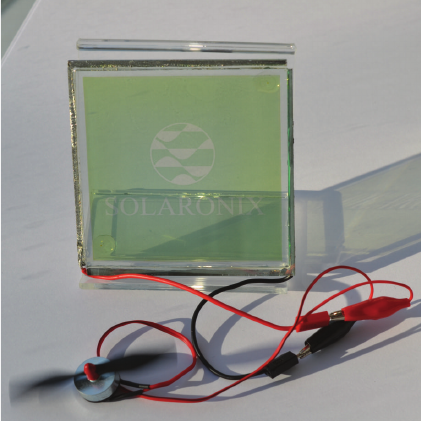
Figure 2: 𝐼 - 𝑉 curve of a DSC with Hepta4 as sensitizer.